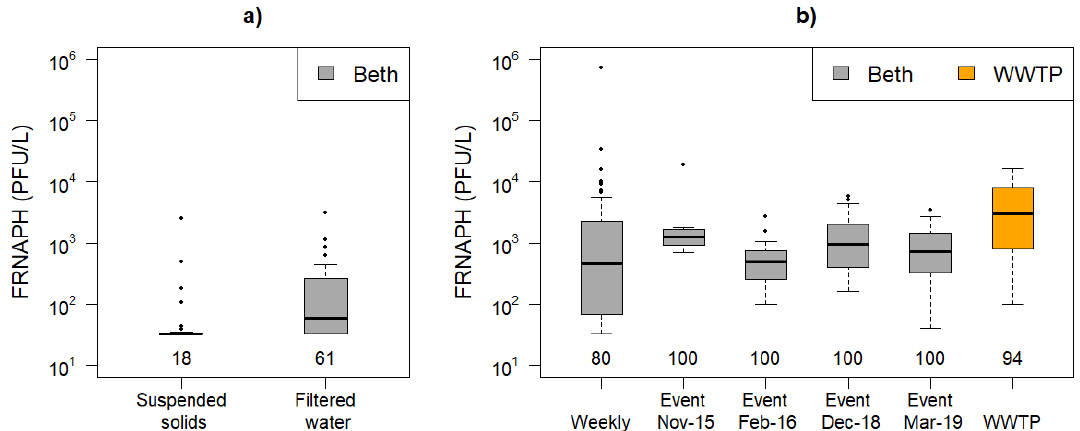
Figure 2. Box plot representation of the F-specific RNA bacteriophage (FRNAPH) concentrations in the Orne River at the Beth sampling location ( a ) in the suspended solids and filtrated water collected during the weekly campaign from February to September 2017 (n = 28; LOQ = 33 PFU/L) and ( b ) in the bulk water samples collected during the weekly campaign (n = 91; LOQ = 33 PFU/L), and the four runoff events that occurred during November 2015 (n = 7; LOQ = 50 PFU/L), February 2016 (n = 13; LOQ = 50 PFU/L), December 2018 (n = 31; LOQ = 33 PFU/L) and March 2019 (n = 50; LOQ = 33 PFU/L), and in the effluent of the wastewater treatment plant (WWTP) at irregular intervals from December 2018 to March 2019 (n = 17; LOQ = 100 PFU/L). Numbers below the boxes indicate % of samples from which FRNAPH were